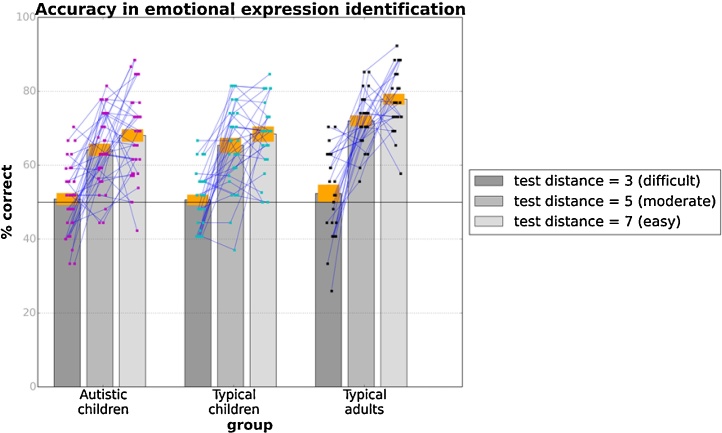
Mean accuracy in face identification task (Task 3) for three values of distance in emotional units between the two faces of the panel for autistic children, typical children and typical adults. Orange bands correspond to ±1 SEM. Points superimposed on bars show individual variability, while blue lines connect data from the same participant.